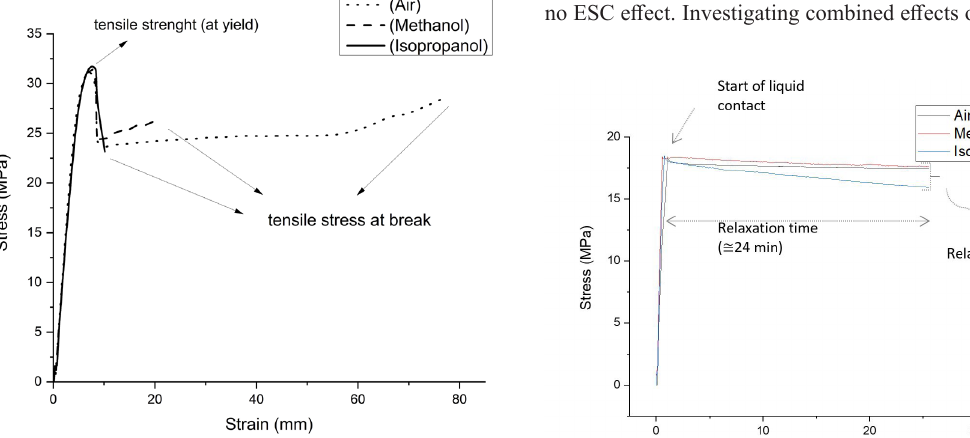
Figure 3. Tensile strength curves (2 mm/min) for Durolon PC in three different environments, showing the most aggressive ESC action of isopropanol.